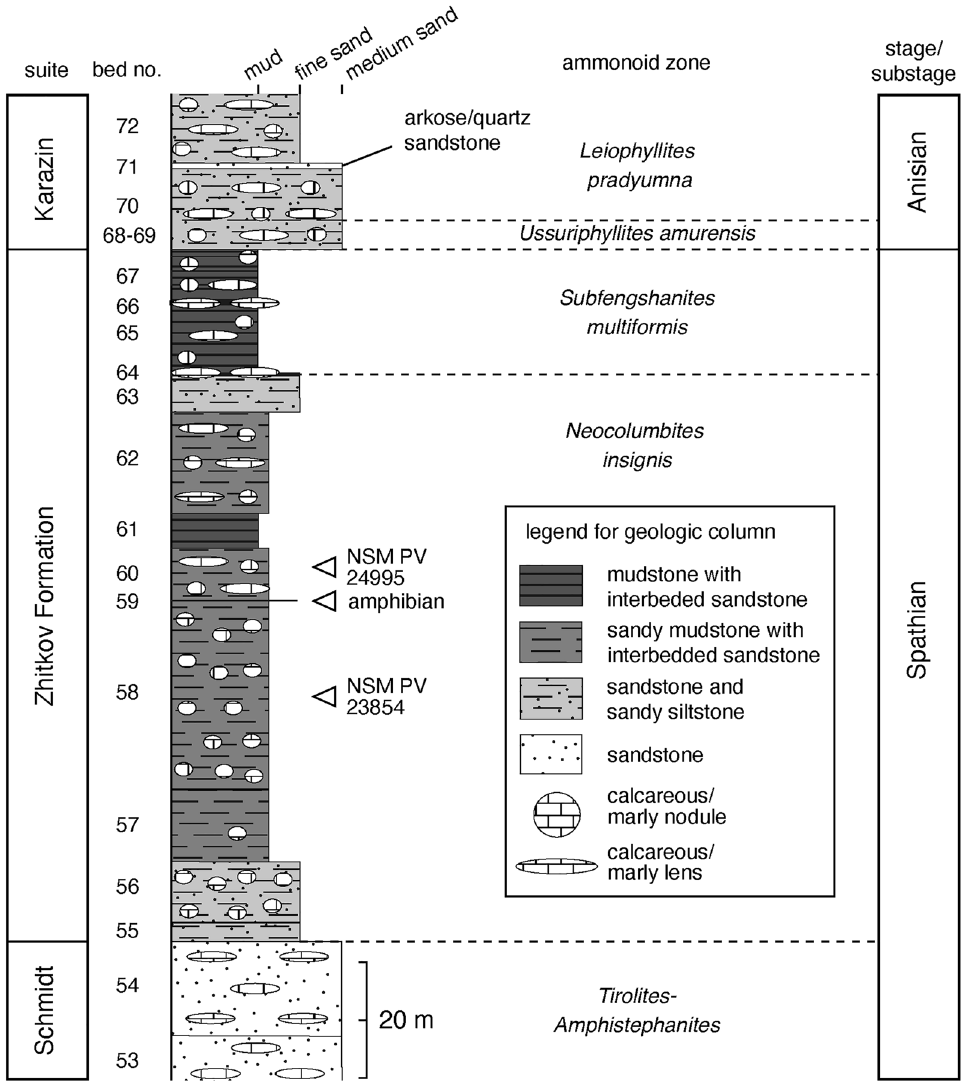
observations of Y.